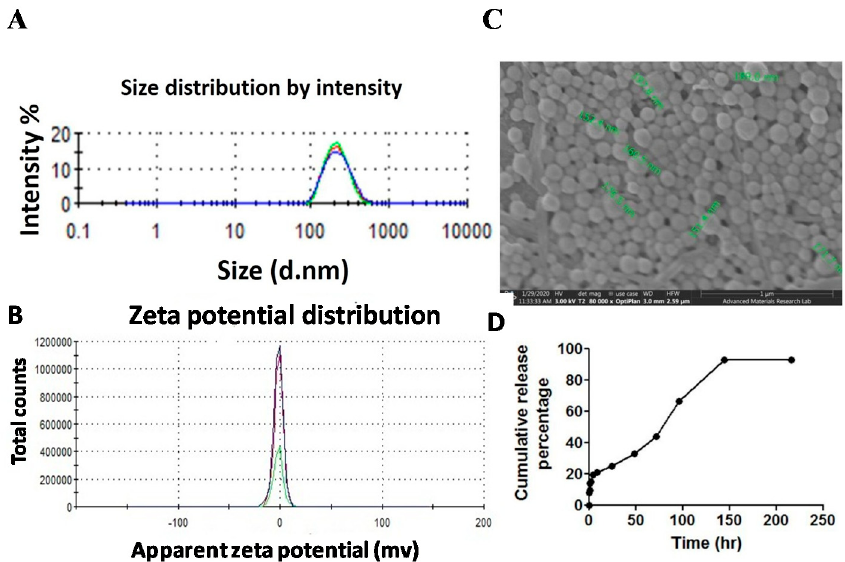
Figure 3. Characterization of nanoparticles. ( A , B ) Particle size distribution and zeta potential measurement using a Malvern Instruments Zetasizer Nano ZS. NPs samples were diluted with distilled water and the polydispersity index ( A ) and zeta potential ( B ) were determined using the Dynamic light scattering (DLS) mode and Laser Doppler Velocimetry (LDV) mode, respectively. The measurement was performed in triplicate. ( C ) SEM micrographs of the developed nanoparticles. The NPs samples after complete dryness were placed on standard carbon tape and coated with gold prior to measurement. ( D ) Release pattern of UoST5-loaded NPs. UoST5-NPs were placed into dialysis membrane (MWCO = 12 kDa) containing 1ml of release media (0.9% NaCl and isopropanol (85:15), then immersed in 10 mL of release media and incubated in shaking water bath at 37 °C and 50 rpm.